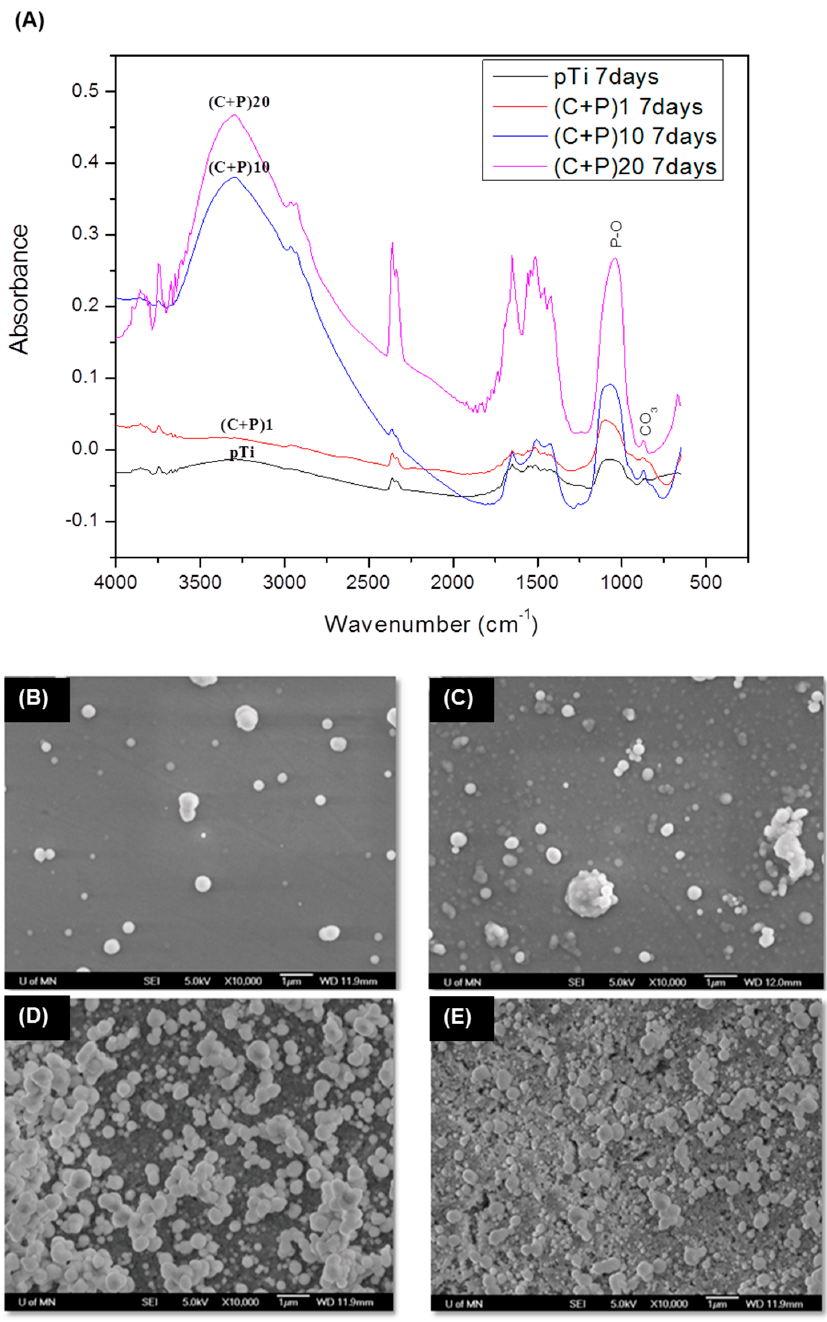
Figure 3. Biomineralization of LbL surfaces. ( A ) DRIFTS spectra of the biomineralized pTi and LbL-coated surfaces; ( B – E ) SEM pictures of biomineralized surfaces ( B ) non-coated pTi surface; ( C ) One bi-layered ((C + P) 1 ); ( D ) 10 Bi-layered ((C + P) 10 ); and ( E ) 20 bi-layered surfaces ((C + P) 20 ).